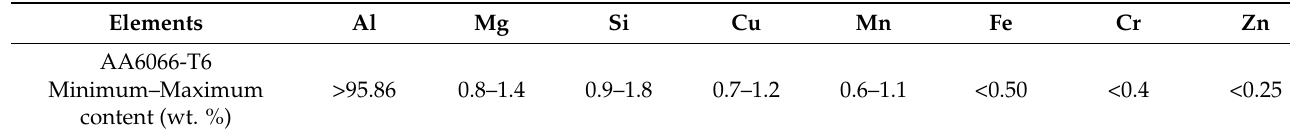
Table 1. Chemical composition of the material.